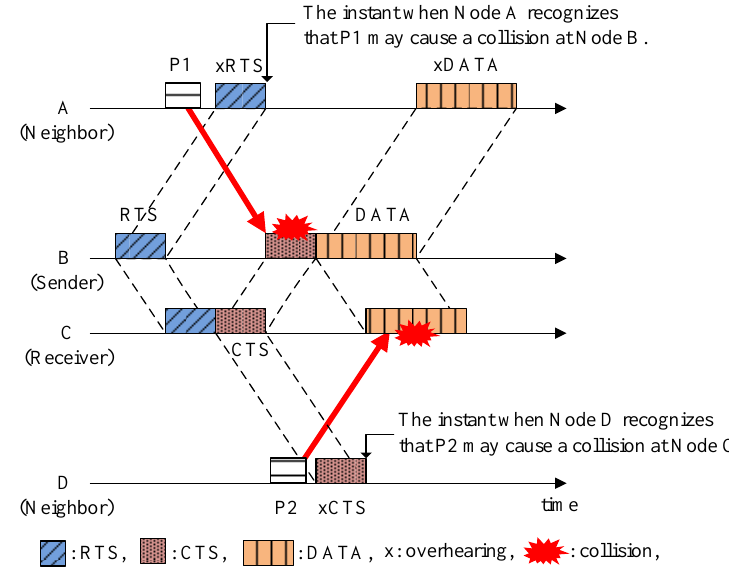
Figure 1. Illustration of the hidden-node problem in UWSNs.